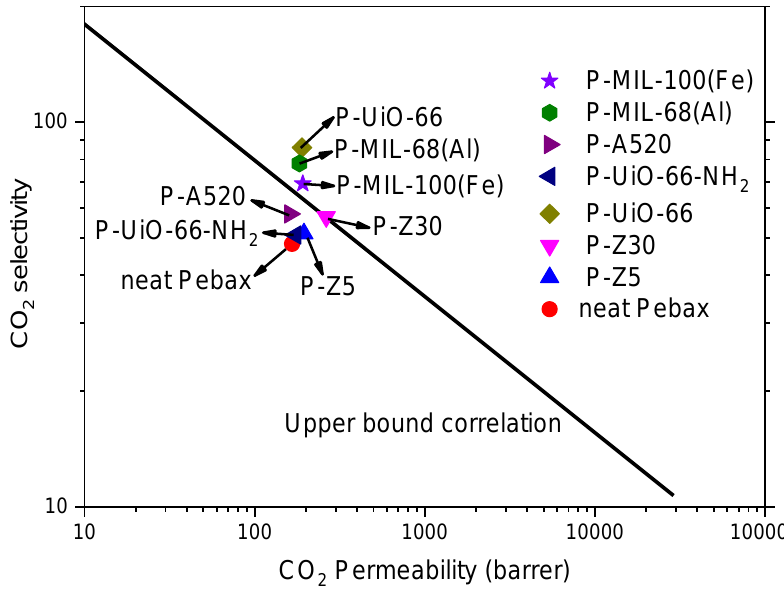
Figure 8. Upper bound correlation (2008).